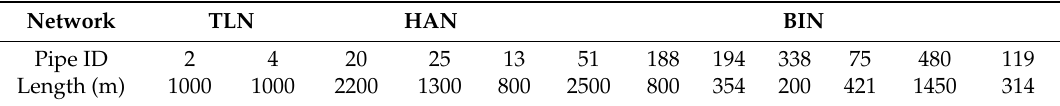
Table 6. Characteristics of closed pipes.